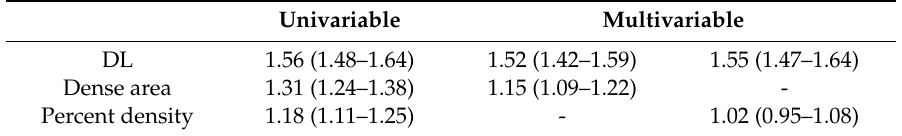
Table 5. Odds ratio per unadjusted standard deviation 1 from Dembrower et al.